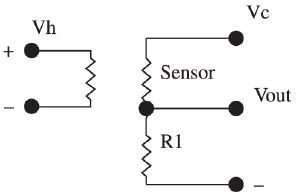
Figure 3. X-ray diffraction of different Sn-doped ZnO annealed at 600 °C for